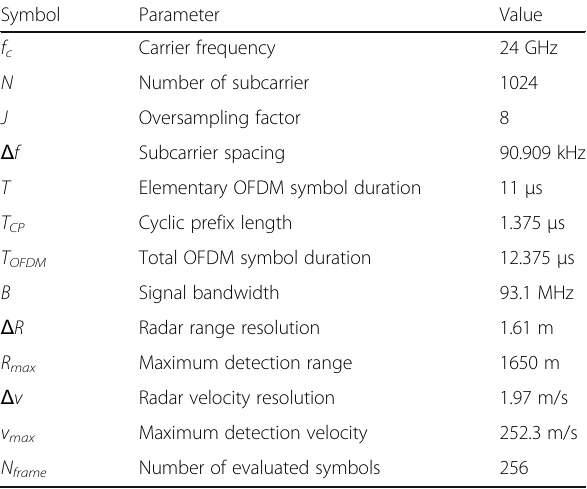
Table 1 CE-OFDM system parameters for vehicle